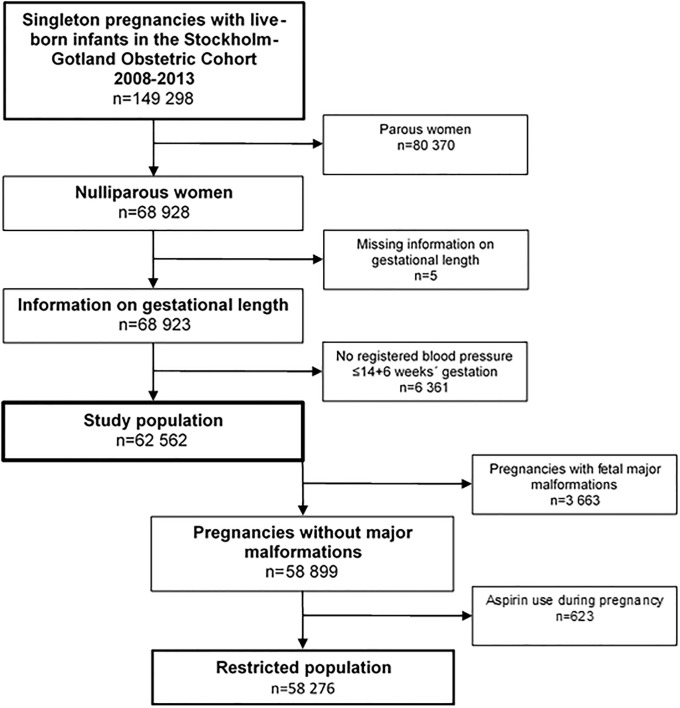
Flowchart of 149 298 included pregnancies of women who were delivering in the Stockholm-Gotland Counties of Sweden 2008–2013.